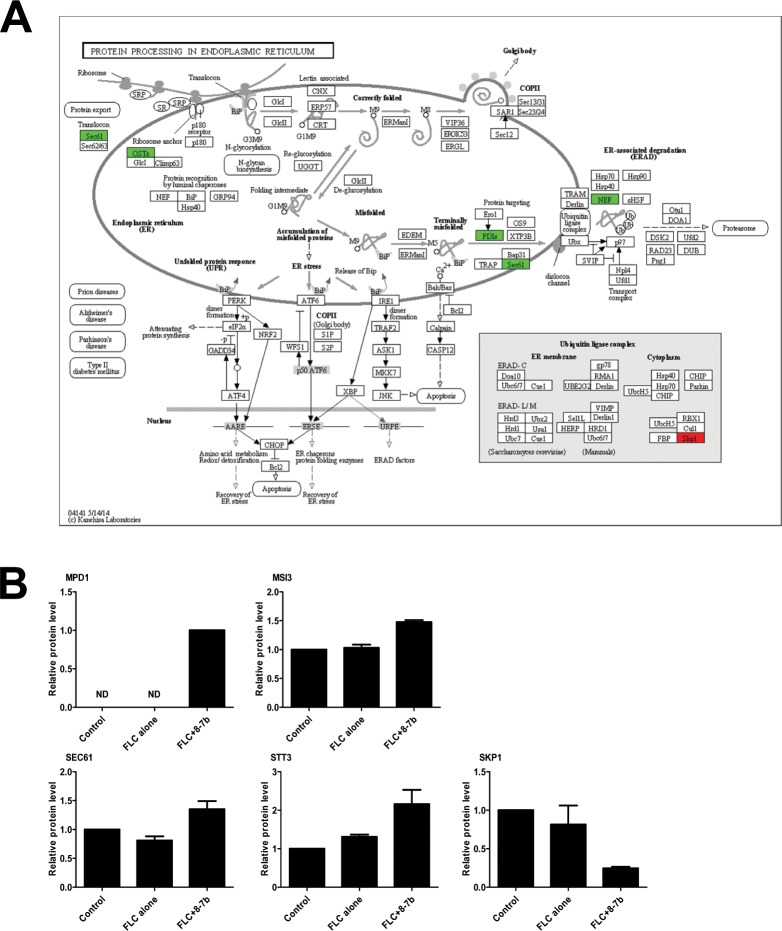
The significant pathway of protein processing in endoplasmic reticulum (p = 0.0329) for differential proteins and the differential protein level in Comparison 3.(A) For each rectangular shape, red shapes indicate down-regulated proteins, while green shapes indicate up-regulated proteins. KEGG pathway analysis figure depicts the role or involvement of a specific protein or a family of related proteins at a particular location in the pathway. (B) The relative protein level of five proteins compared to Control, corresponding to colored rectangular shapes in A, respectively.